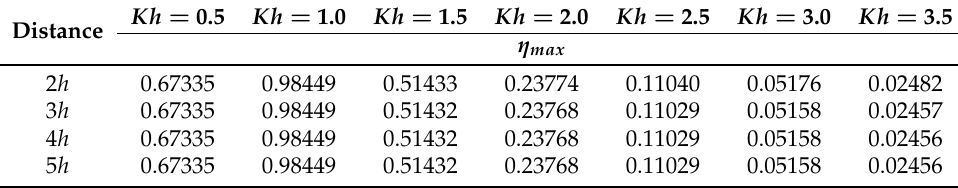
Table 2. Calculation of the maximum hydrodynamic efficiency η max by using the BEM for different distances at which the left and right radiation boundaries are truncated a 1 / h = a 2 / h = 0.5, w 1 / h = w 2 / h = 0.125 b / h = 1.0 and h e / h = 1 without the reflecting vertical wall.